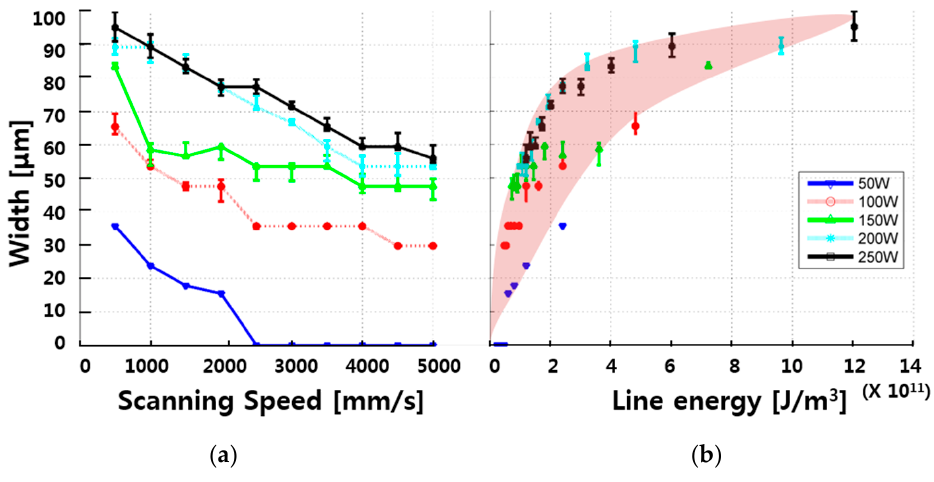
Figure 3. ( a ) Top width VS. Scanning speed; ( b ) Volume energy.